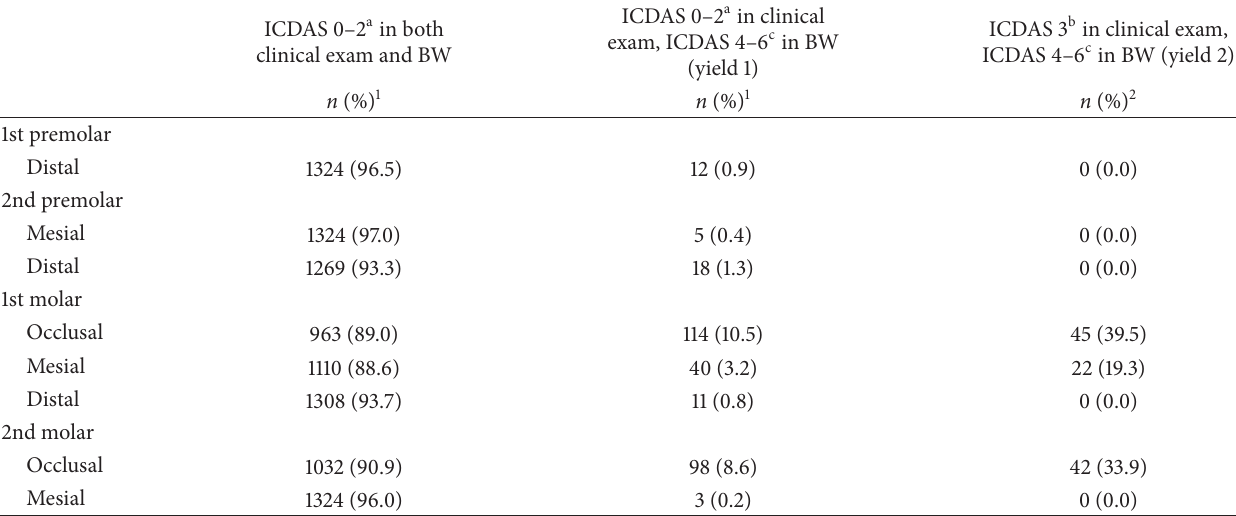
Table 2: Number of ICDAS 0–2 surfaces in both clinical examination and with BW included and number of surfaces with yield from radiographs.